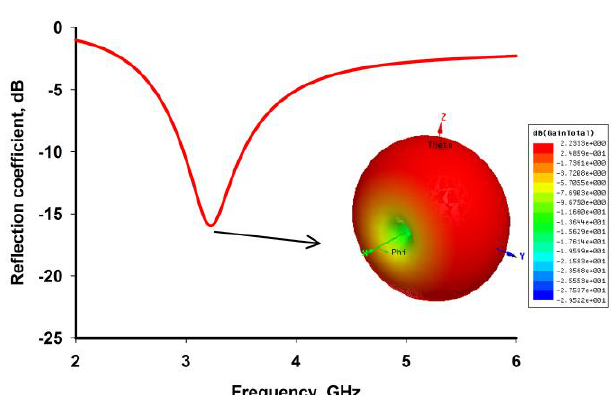
Figure 5: Reflection and radiation characteristics of the dipole